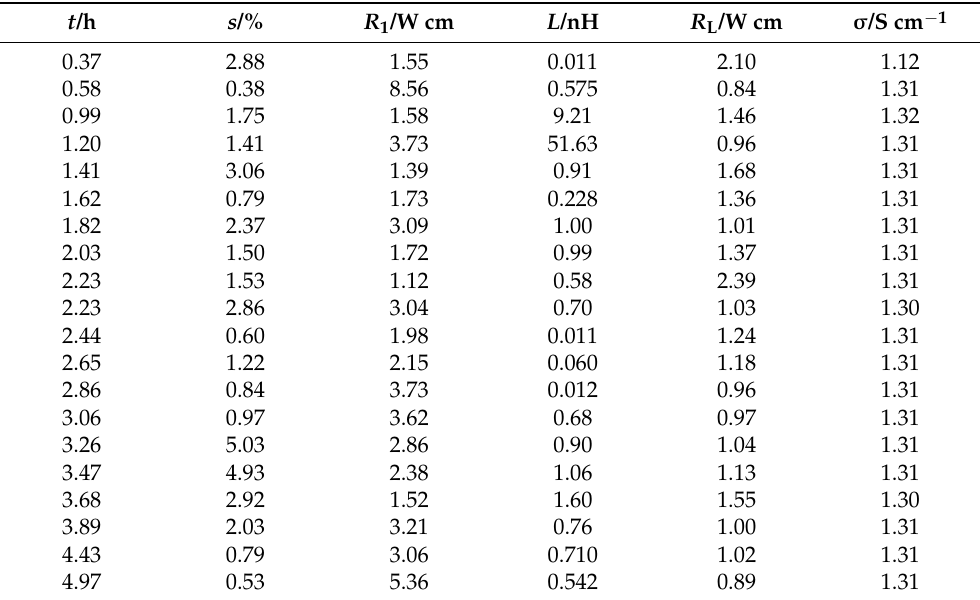
Table 4. Results of fitting the impedance spectra recorded during the second reduction in 5% H 2 –Ar gas atmosphere ( t —time elapsed from the beginning of the experiment; s —standard deviation; fitted parameters (for the EEC presented in Figure 14b): L —inductance; R L and R 1 —resistances; σ —electrical